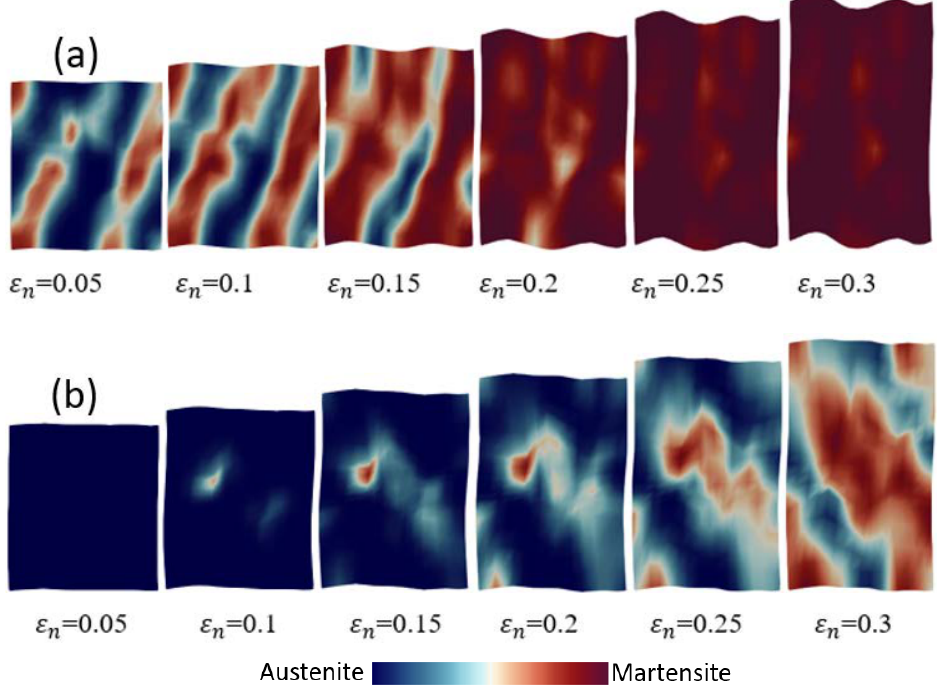
Figure 14. The distribution of martensitic phase of 4-grain polycrystal TRIP steel with a preferred orientation of ( a ) ∅ = 30 ◦ and ( b ) ∅ = 60 ◦ .